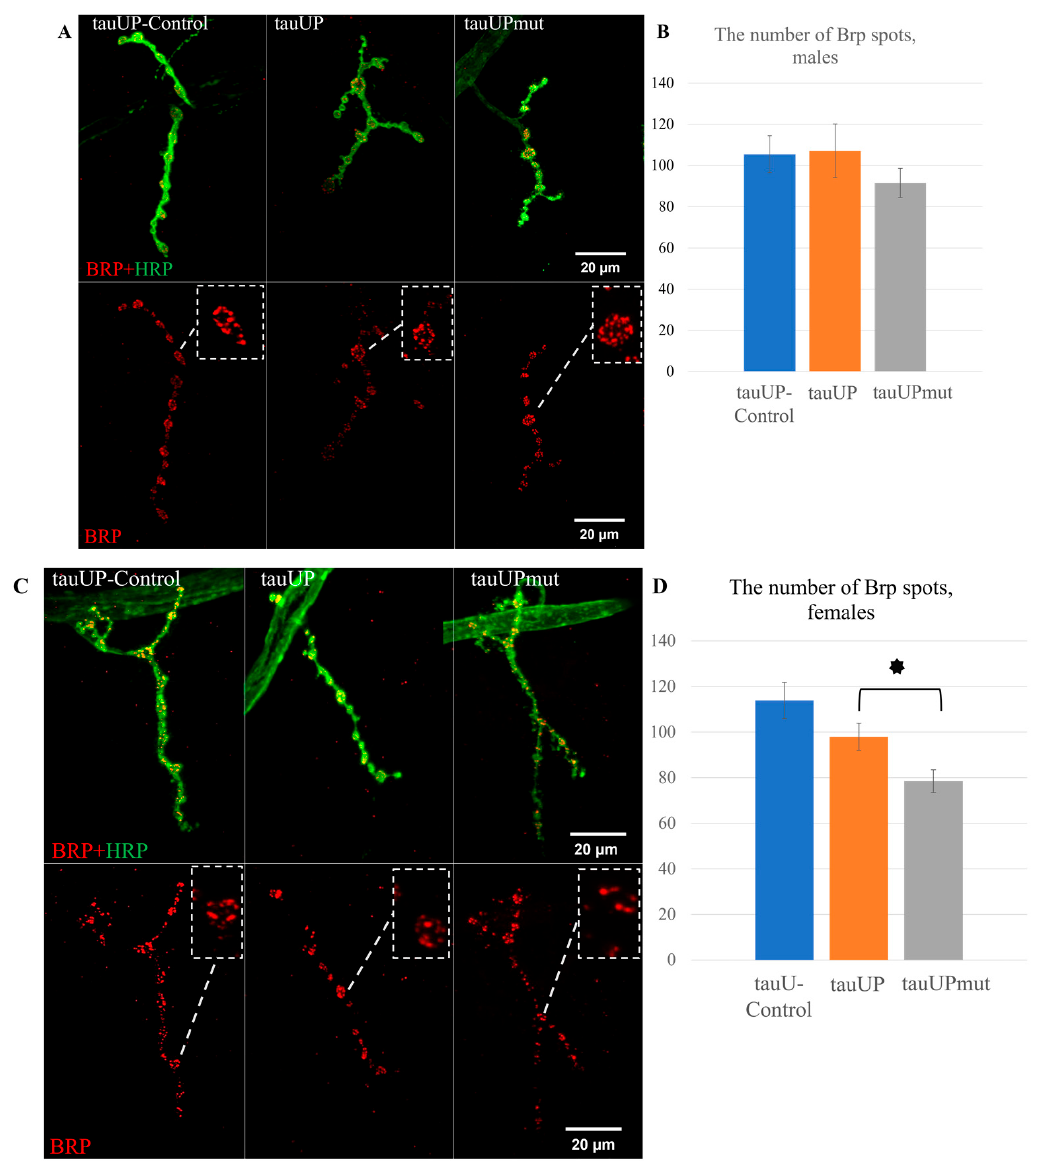
Figure 5. Increased expression of the normal and mutant RA transcript of the tau gene does not change the number of Brp spots in synaptic contacts in males and decreases it in females. ( A , B )—Immunostaining and the mean number of Brp spots in males. ( C , D )—Immunostaining and the mean number of Brp spots in females. A detailed description of the genotypes is given in the Materials and Methods section. * p < 0.05.